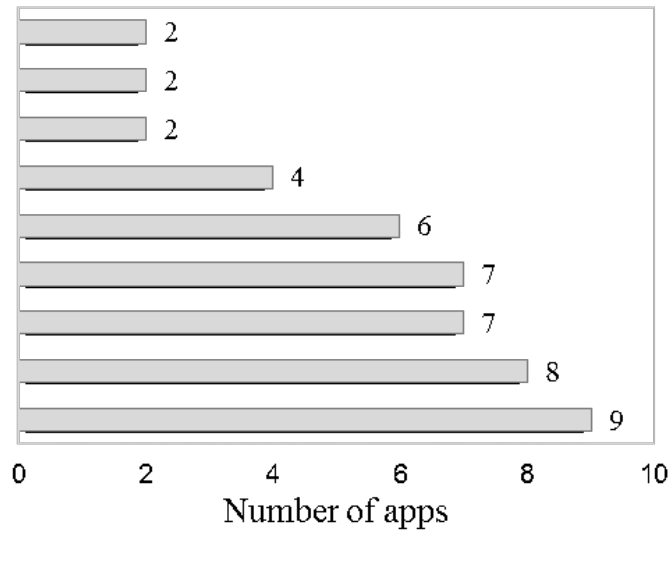
Figure 4. App features covered in apps developed by maternal and child health